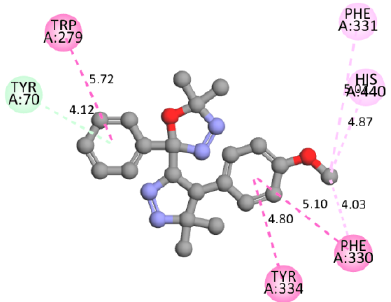
Figure 8. 2D depiction of docking of ligands 1HP14 and 1HP24 in the active site of AChE (PDB ID: 1ACJ).